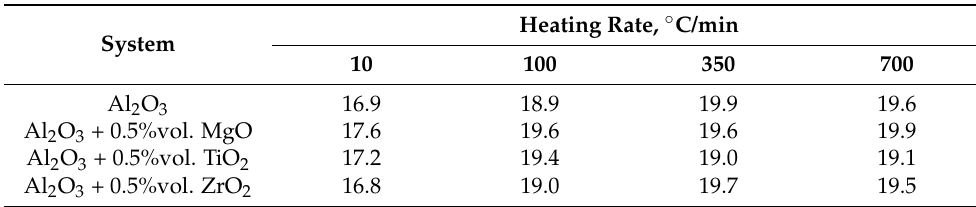
Table 3. Effective activation energy of sintering Q , kT m on the first stage of sintering (the accuracy of the determination of Q is 2 kT m ).